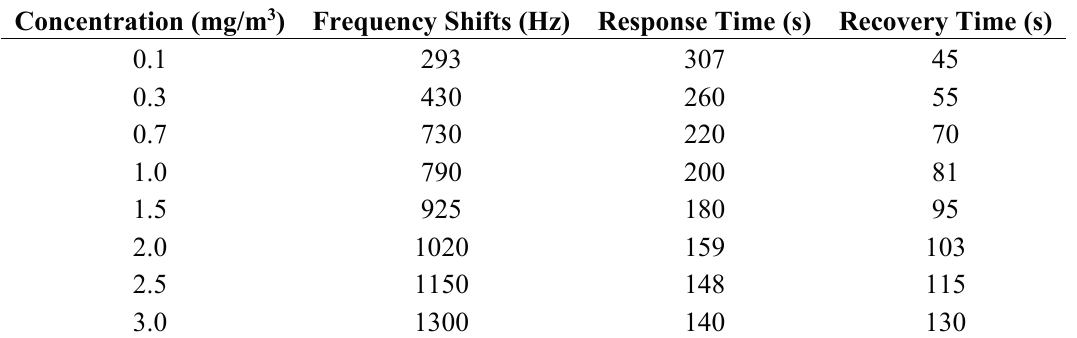
Table 1. Responses of the SAW-MIP sensor to different concentrations of GB (Temperature = 25 °C, Relative Humidity =